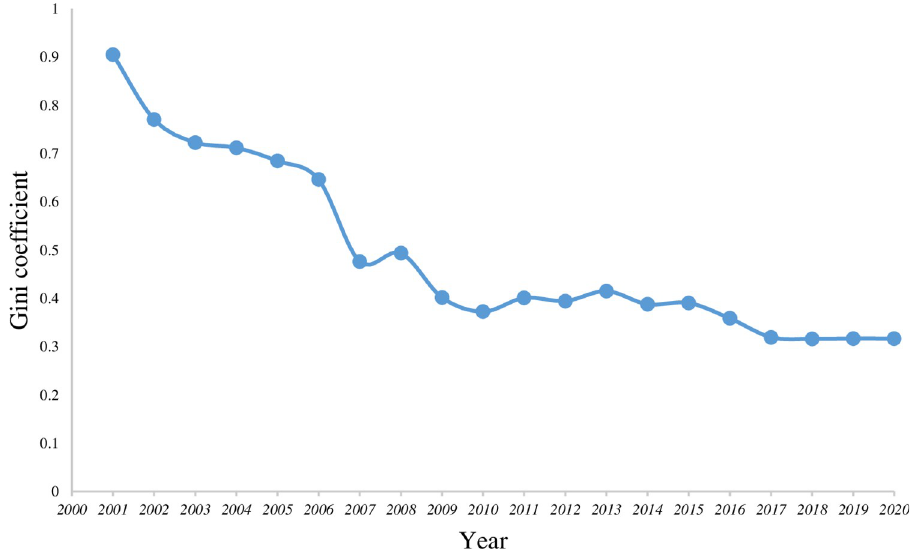
Fig 2. Transformation of Gini